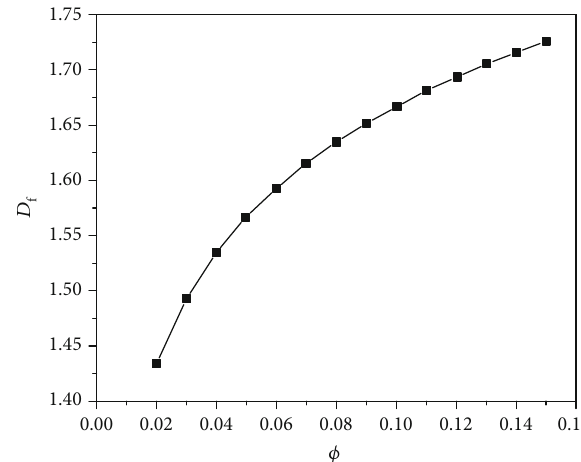
and θ ( D = 1 : 4 , D = 1 : 1 , xx f T